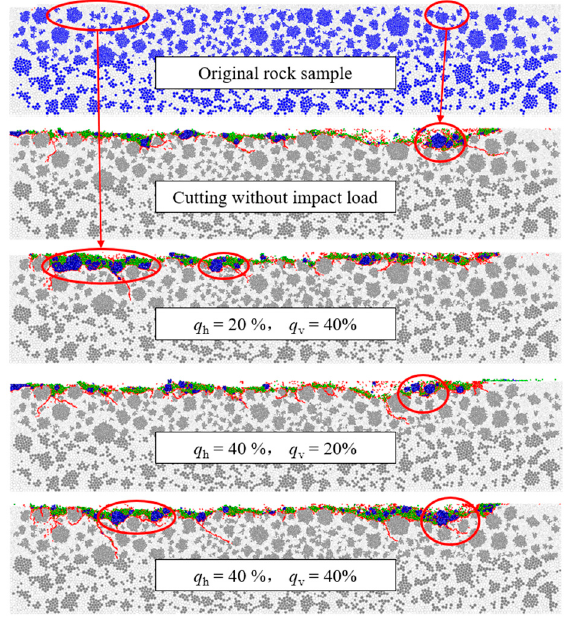
Figure 13. Broken state of the rock samples under different impact loading.